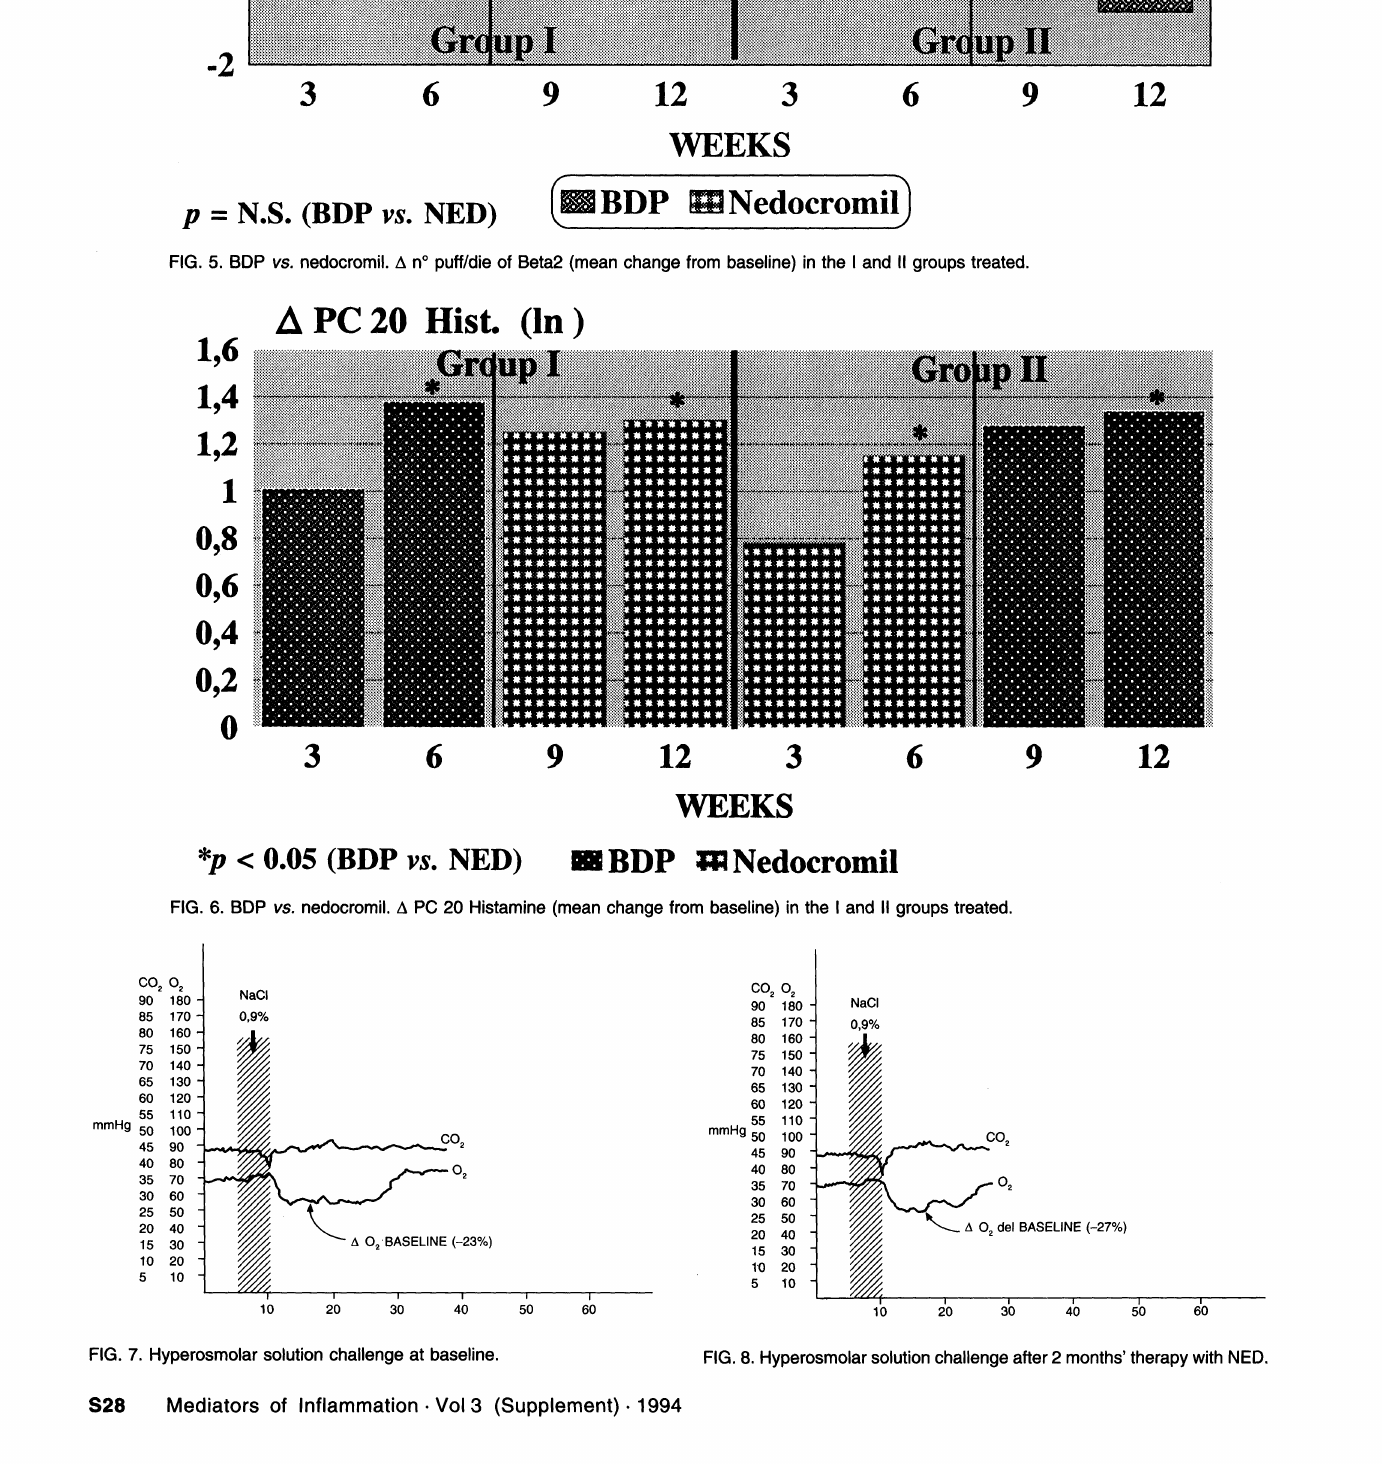
FIG. 8. Hyperosmolar solution challenge after 2 months’ therapy with